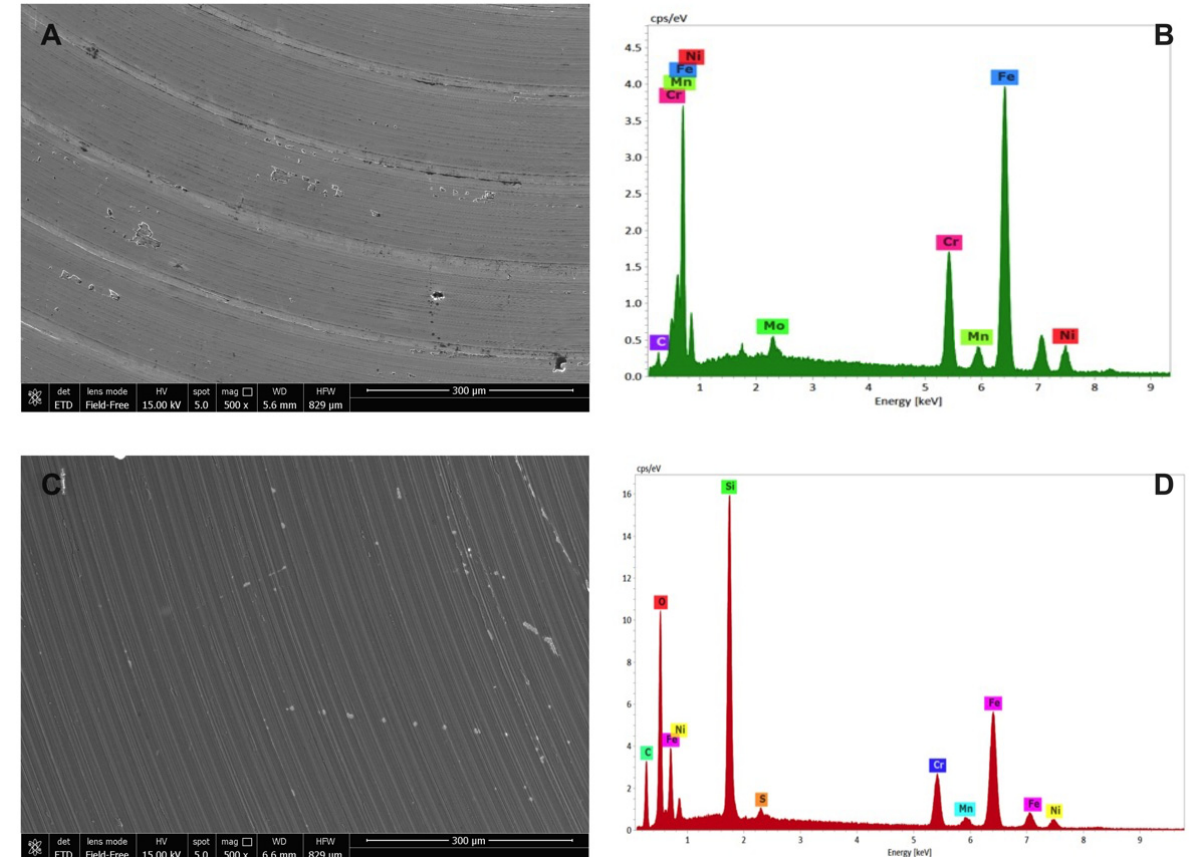
Figure 6. Environmental scanning electron microscope morphological analysis on ( A ) uncoated and ( C ) SiO x C y H z -coated stainless-steel disks observed at 300 μ m, along with their respective ( B , D ) X-EDS microanalysis.